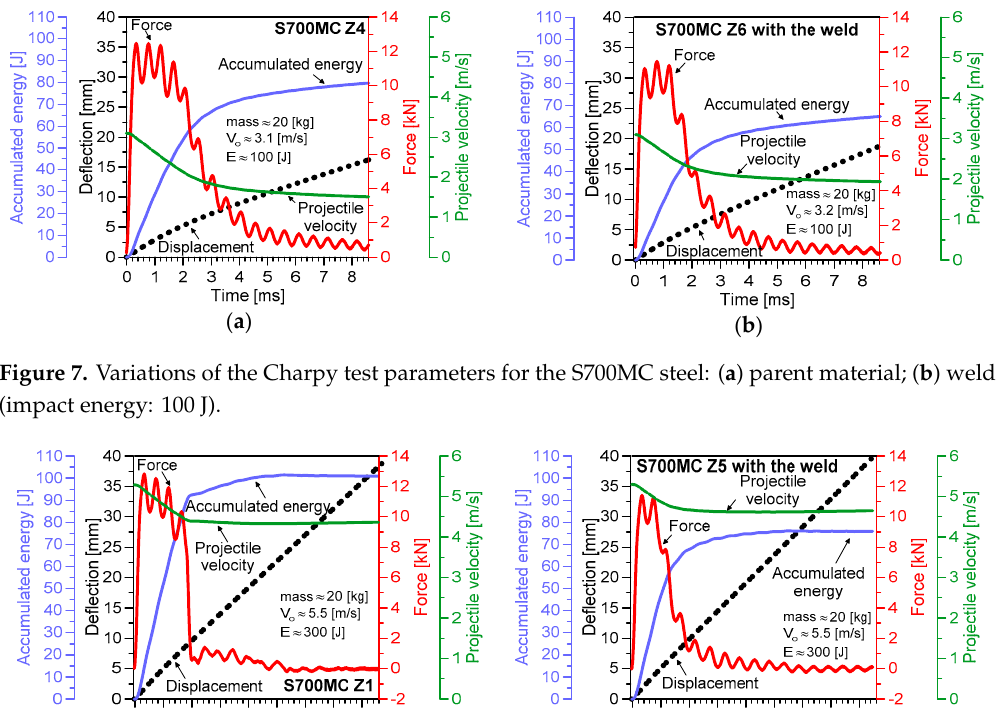
Figure 6. V-notched specimens of the parent material and weld of S700MC steel after Charpy test: ( a ) —specimen after test; ( b , c )—fracture zone from side and top view, respectively.